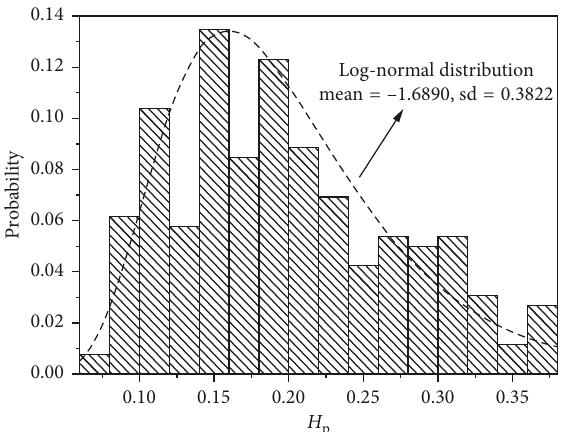
Figure 4: The probability of H p and lognormal distribution curve.